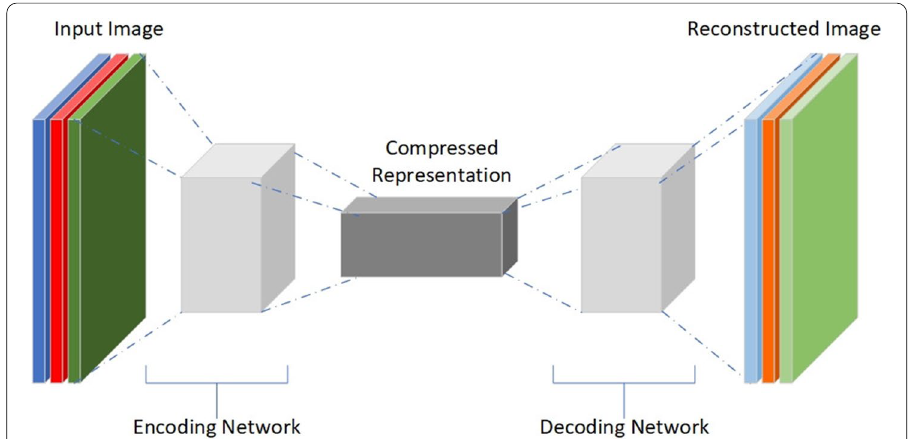
Fig. 4 A typical architecture of an autoencoder